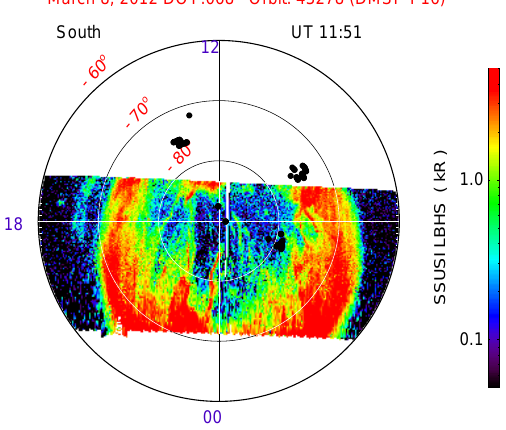
Figure 13. SSUSI (DMSP F16) auroral image scans mapped as a function of magnetic latitude and MLT. Superposed are IPPs (black dots) where scintillation σ (cid:56) or sDPR exceeded 0.1rad or 2mms − 1